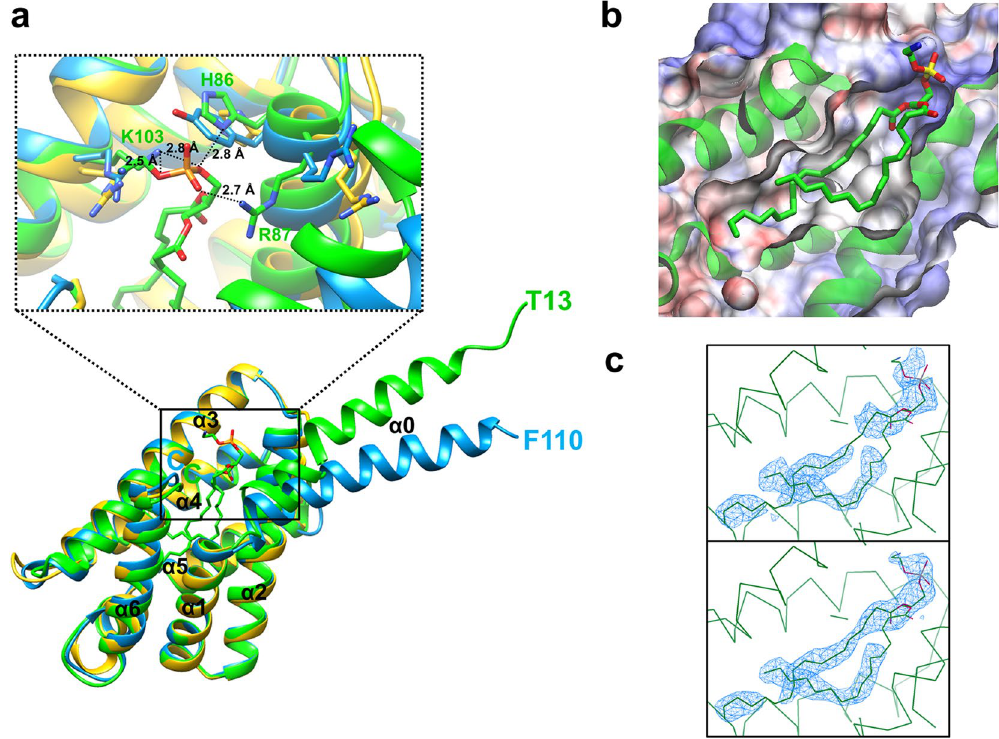
Figure 2. Structural analyses of mTnfaip8. ( a ) The superimposed crystal structure of mTnfaip8 (green) with that of hTIPE2 (gold; PDB ID: 3F4M) and hTIPE3 (sky blue; 4Q9V) are shown. The entrance of the cavity is highlighted in the solid box. The starting N-terminal residues are labeled according to their ribbon colors. The zoomed view represents the binding mode of PE in the highlighted region. ( b ) The hydrophobic cavity of mTnfaip8 with PE. ( c ) The composite omit map (upper) and the 2Fo-Fc electron density map (lower), contoured at the 0.9 σ level, for the region of PE are shown in blue